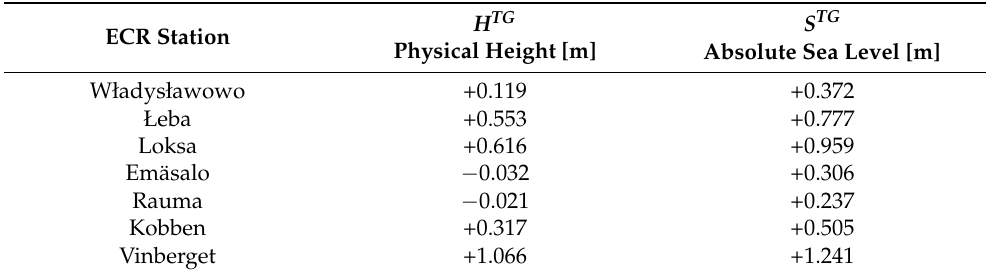
Table 12. Physical heights H TG of TG stations as computed from the ECR ellipsoidal height, the local tie from the ECR to the TG and the quasi-geoid height. Absolute sea level heights S TG from physical heights and tide gauge readings. H TG S Physical Height [m]